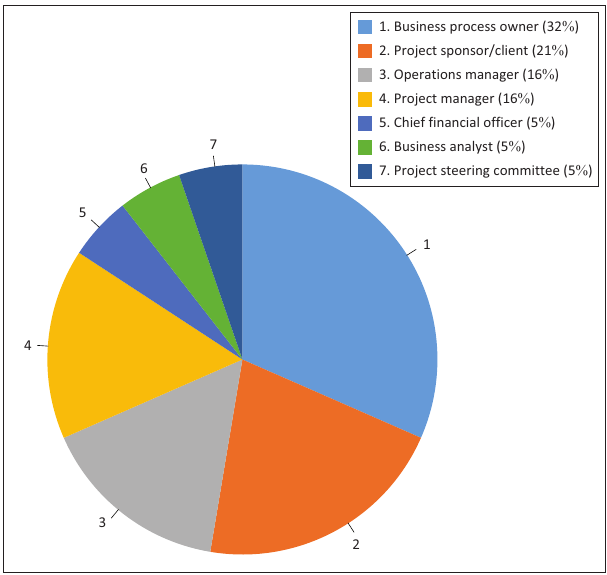
FIGURE 3: Role best suited as benefits